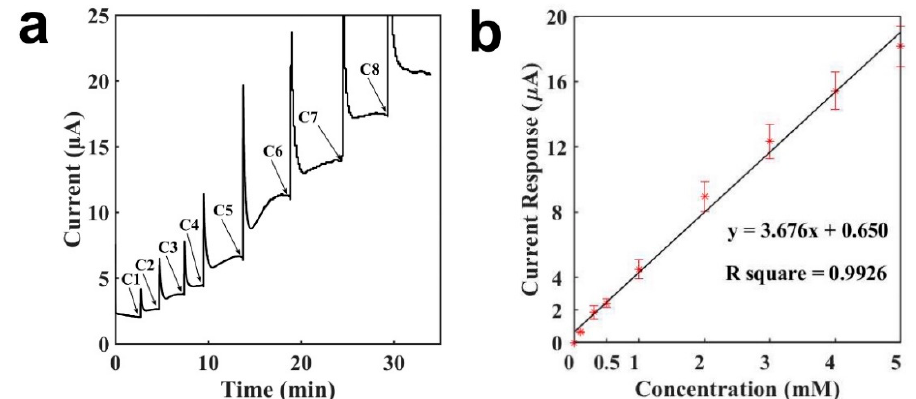
Figure 3. Characterization of the tongue-depressor amperometric sensors for H 2 O 2 (phosphate buffer: 90 μ L, droplet of H 2 O 2 of different concentrations: 10 μ L). ( a ) Current-versus-time curve for the detection of H 2 O 2 ; ( b ) Calibration curve for the detection of H 2 O 2 . C1: 0.1 mM, C2: 0.2 mM, C3: 0.2 mM, C4: 0.5 mM, C5: 1 mM, C6: 1 mM, C7: 1 mM, C8: 1 mM.